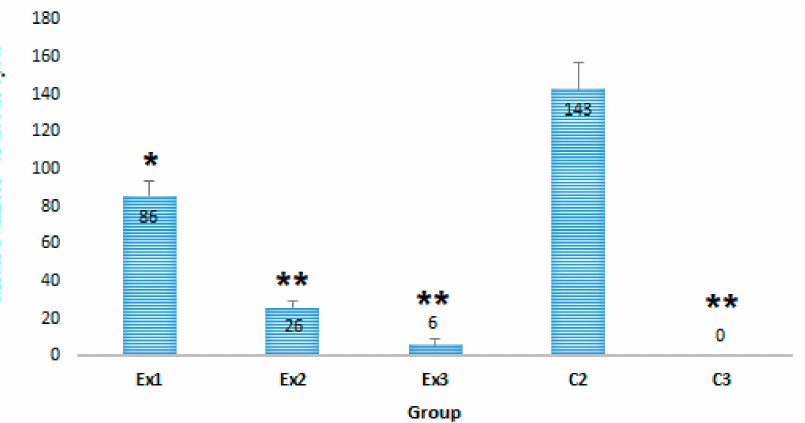
Figure 1. The mean numbers of brain tissue cysts in mice of tested group. The results demonstrated that the mean number of T. gondii tissue cysts in experimental groups Ex1 ( p < 0.05), Ex2 ( p < 0.001), and Ex3 ( p < 0.001) was meaningfully reduced as a dose-dependent manner compared with control group (C2). * p < 0.05, ** p < 0.001.